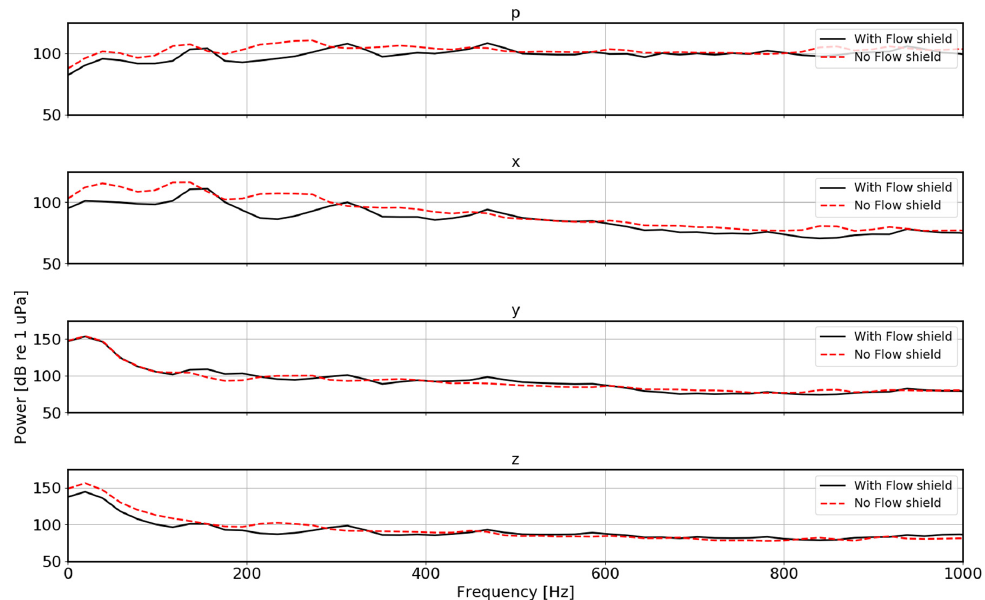
Figure 6. Ambient noise frequency spectra for the pressure and particle velocity channels, with and without the flow shield.